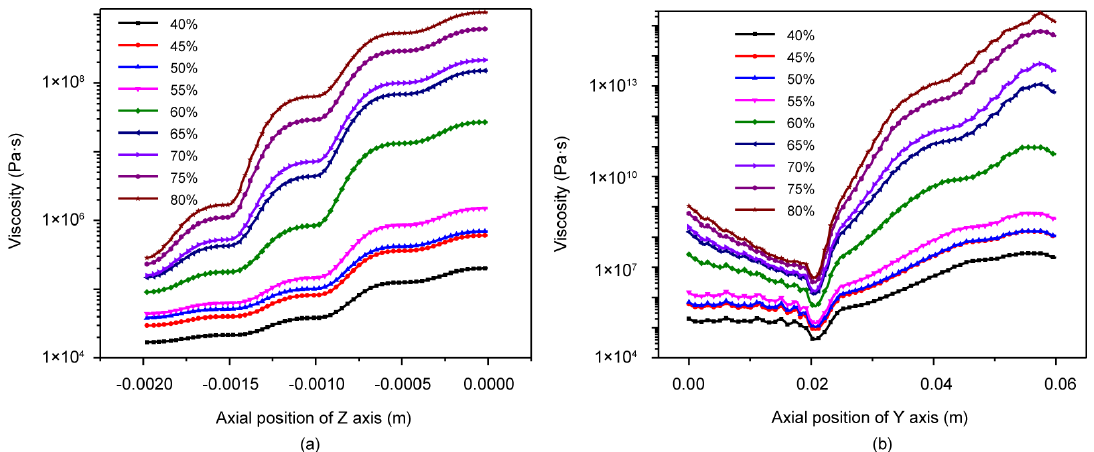
Figure 8. Viscosity distribution graph on the centerline along the ( a ) z -axis and ( b ) y -axis.